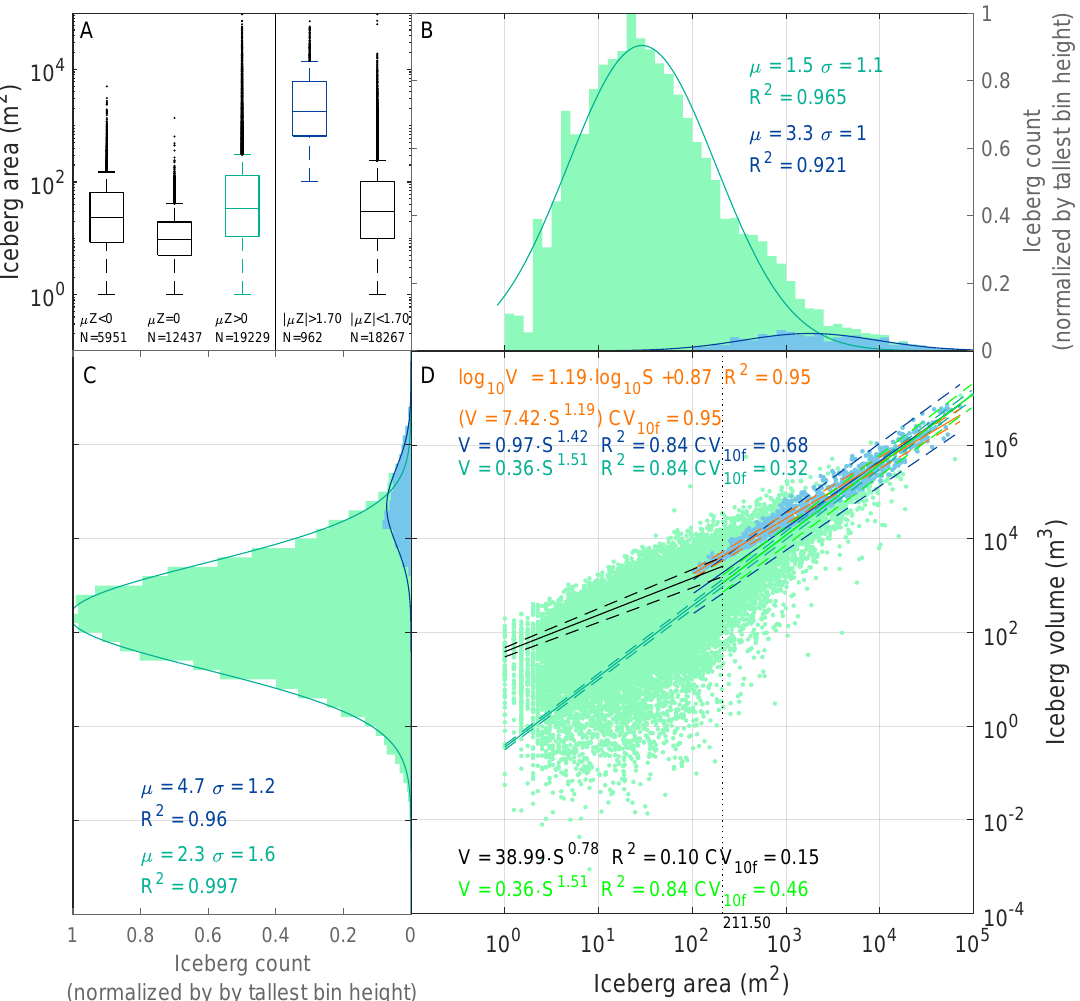
Figure 13. Results of filtering and model fitting to the area–volume data. Unmodified DREM with negative values used: ( A ) area distributions of iceberg classes selected by µ Z rel ; ( B ) histograms of iceberg area; ( C ) histograms of iceberg volume; and ( D ) power law relationship fitted to the area/volume data. Green fields indicate whole µ Z rel > 0 dataset, blue—data filtered. Green lines are models (Gaussian distributions in ( B , C ), power law models in ( D )) fitted to unfiltered data, blue—to the filtered data. Orange line is a linear model fitted to the log-log data. Dashed lines indicate 95% confidence intervals of